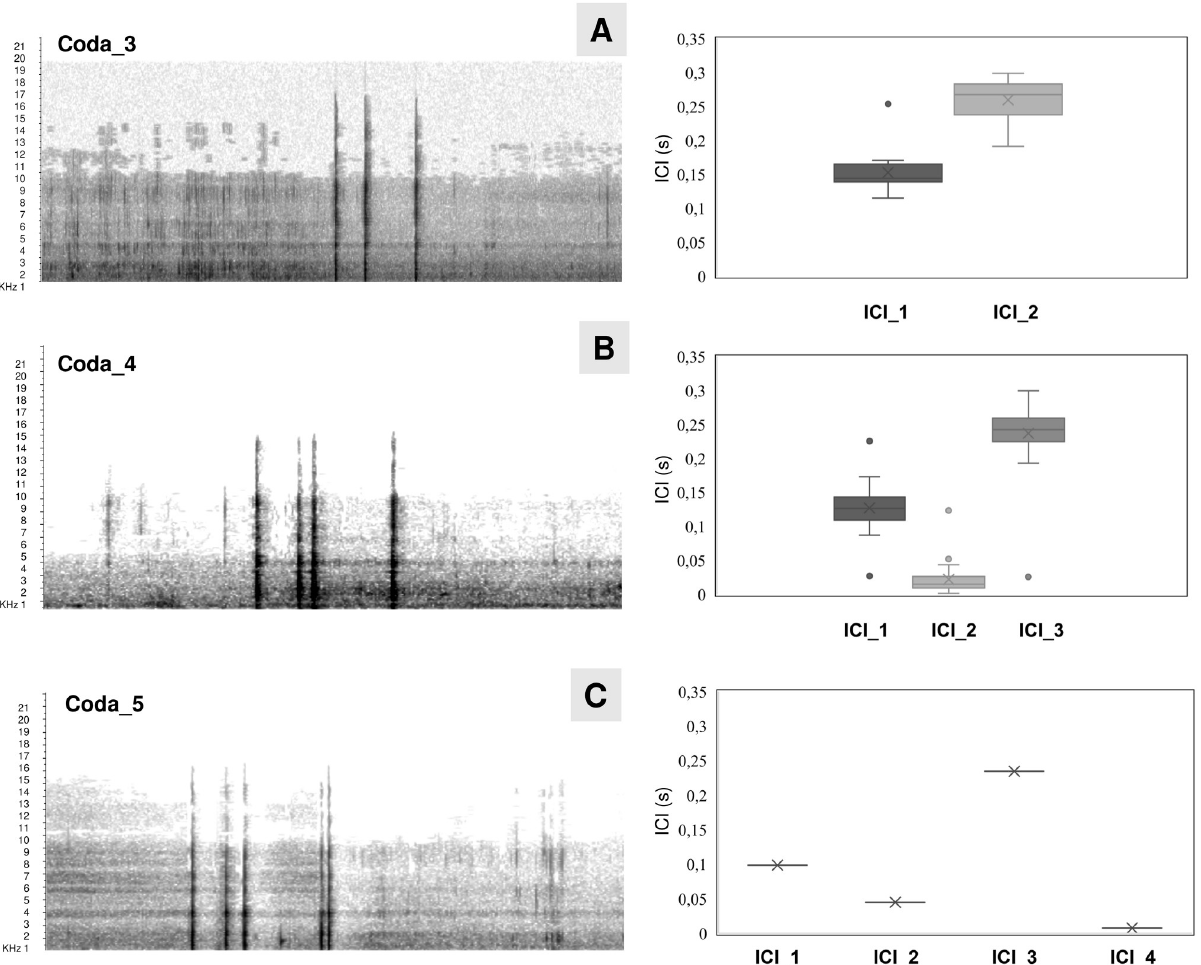
Fig 9. Spectrograms of coda types and related inner-coda ICIs (s). A) coda_3 (3-clicks). B) coda_4 (4-clicks). C) coda_5 (5-clicks). ICI_1 = ICI between the first and the second click; ICI_2 = ICI between the second and the third click; ICI_3 = ICI between the third and the fourth click; ICI_4 = ICI between the fourth and the fifth